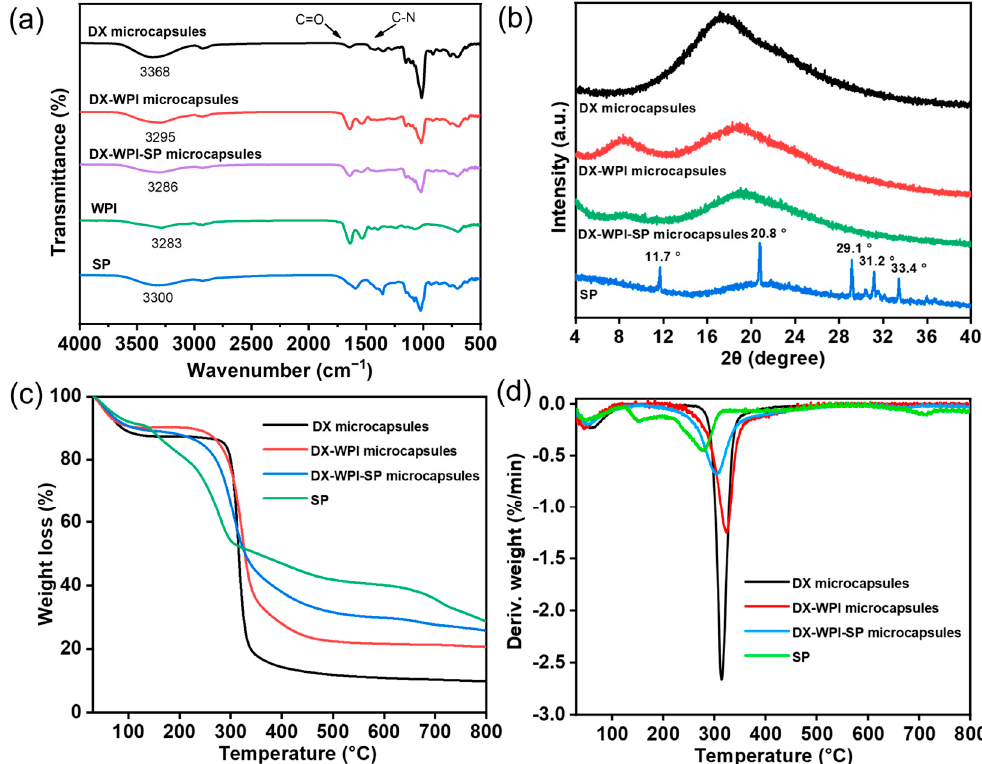
Figure 3. ( a ) FTIR curves, ( b ) XRD patterns, ( c ) TGA curves, and ( d ) DTG curves of DX microcap- sules, DX-WPI microcapsules, DX-WPI-SP microcapsules, WPI, and